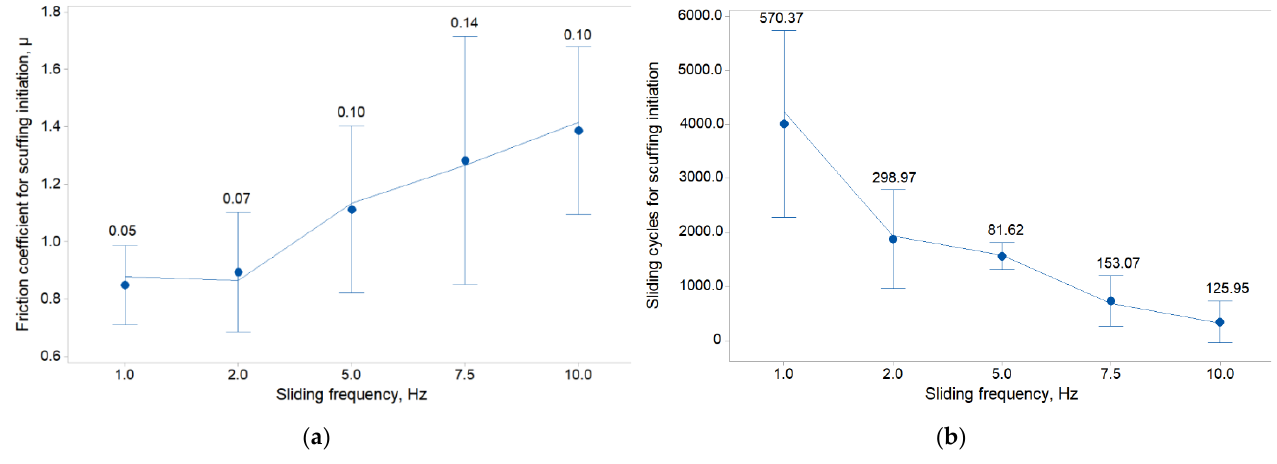
taken after the test was stopped, caused by a sudden increase in the friction coefficient 275 Figure 7. Interval plots of the scuffing initiation, related to: (a) friction coefficient; (b) sliding cycles. 236 Figure 7. Interval plots of the scuffing initiation, related to: ( a ) friction coefficient; ( b ) sliding cycles. value. There are visible local damages to the surface, called adhesive cavities. 276